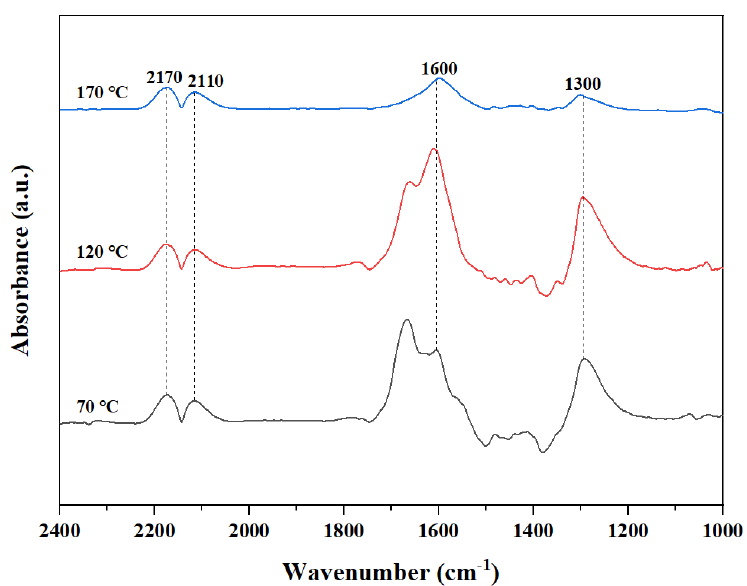
Figure 11. In situ DRIFTS spectra of the 5Ni/OMS-2 sample in a 1.08 vol% CO/air (balance) feed gas at different temperatures.